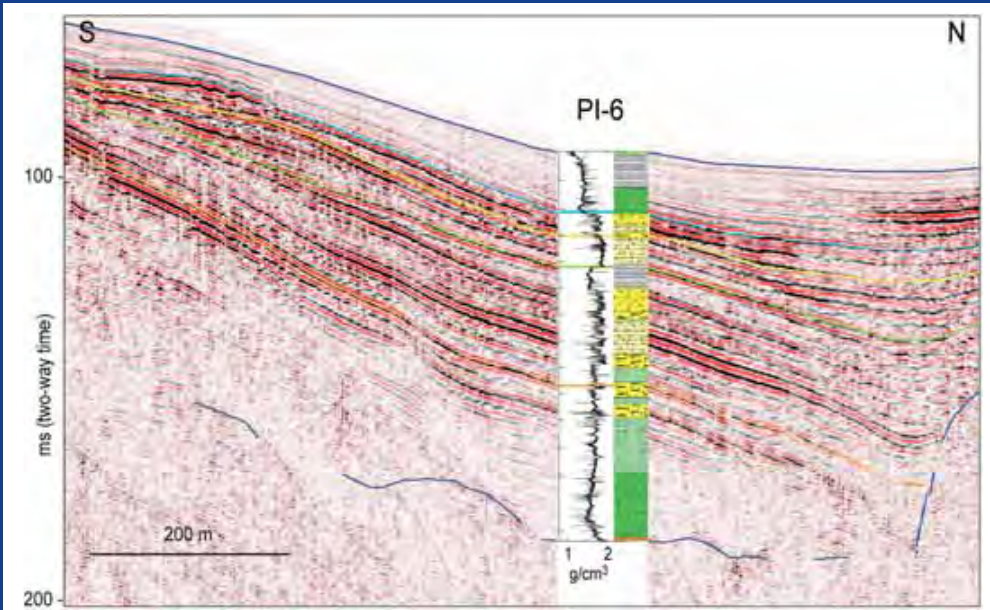
Figure 4. Composite record of MSCL-bulk density and lithology superimposed on seismic data for Site PI-6. Color code of lithologic section is indicated in Figure 3.